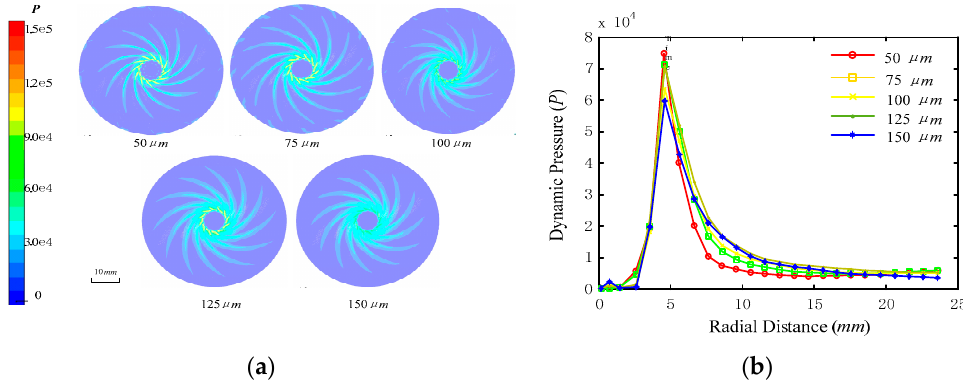
Figure 5. Distribution of dynamic pressure: ( a ) distribution of dynamic pressure under different fluid film thickness, and ( b ) average dynamic pressure along the radial distance of the disc polishing tool.